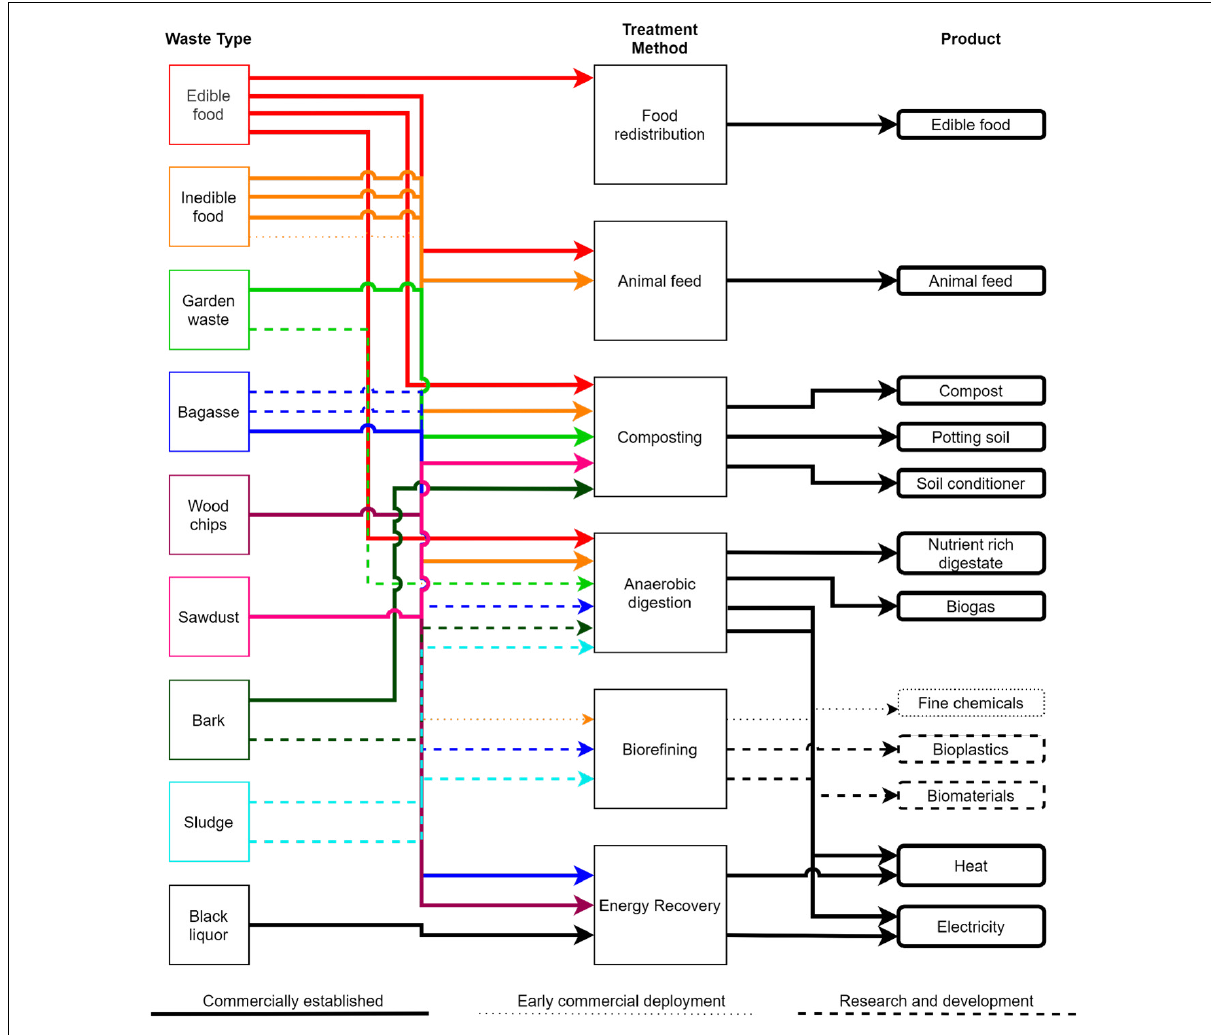
Figure 3: Organic waste treatment methods in South Africa, characterised according to technology